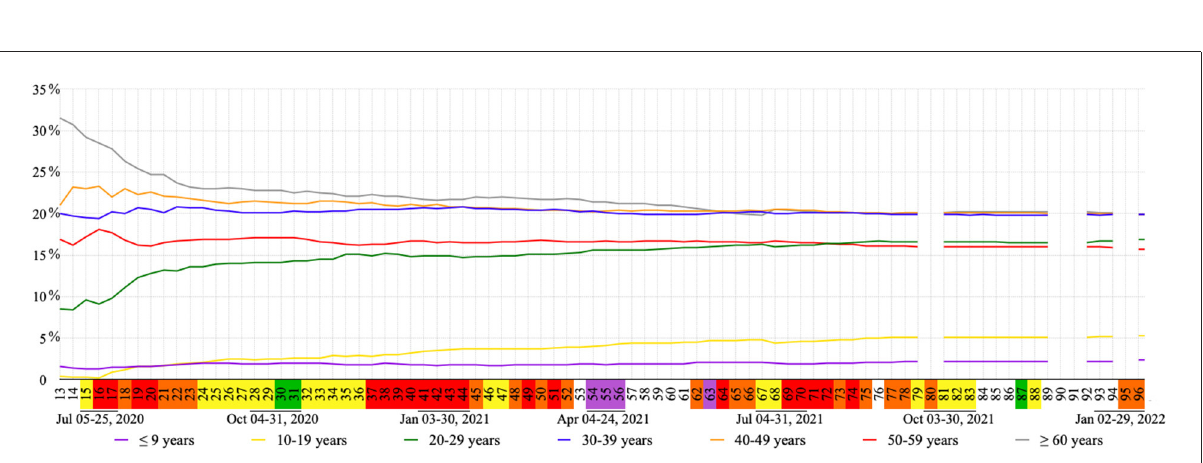
FIGURE5 Percentage of accumulated COVID-19 cases per week in each age group. Flag colors: Green, very low; yellow, low; orange, moderate; red, high; purple, very high risk.